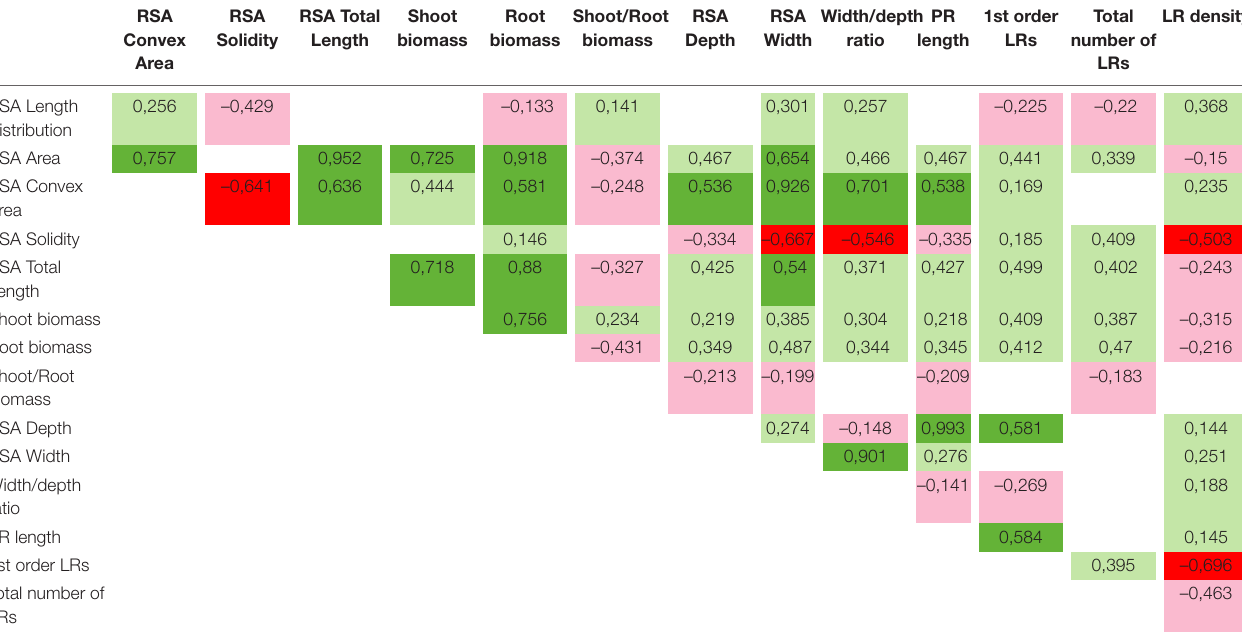
TABLE 2 | Correlation analysis between 15 RSA traits, based on p -Values.